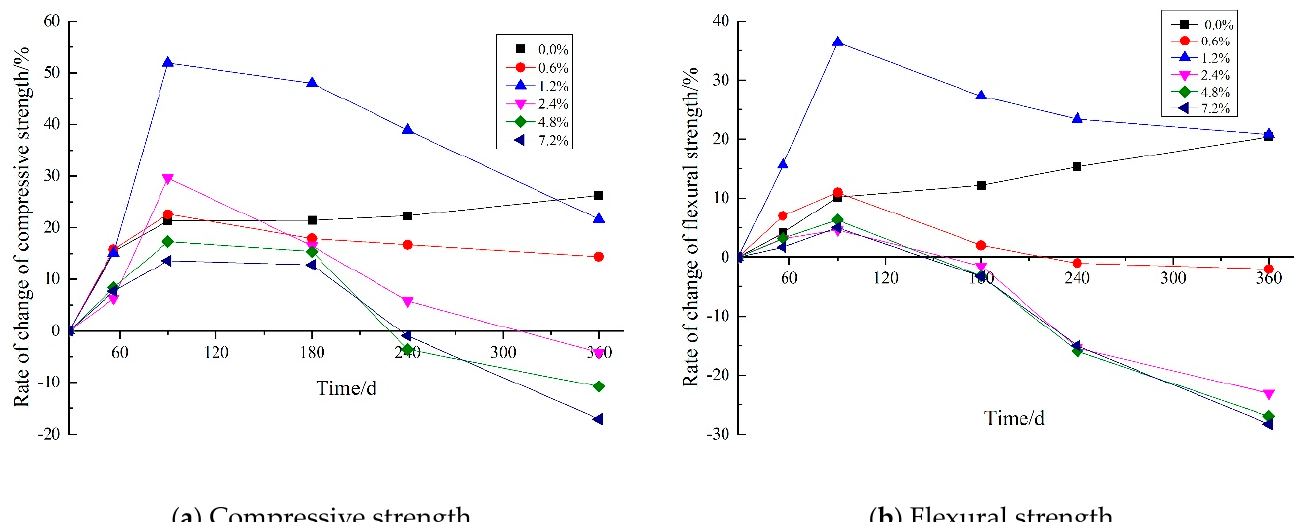
Figure 14. Ratio of strength change in mortars with different SO 3 content in aggregate.